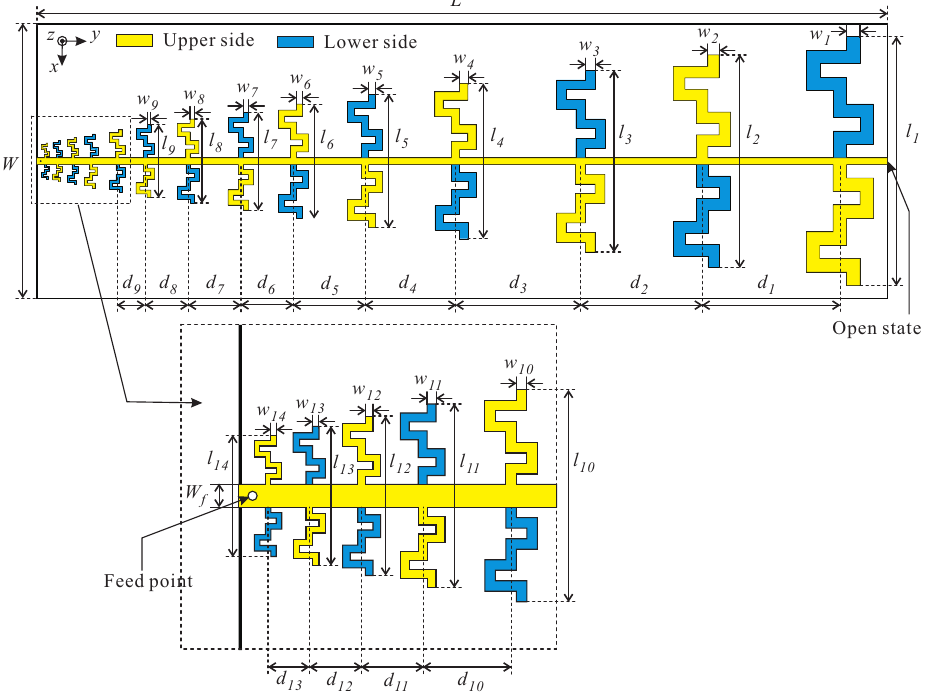
Figure 1. Configuration of the log-periodic meandered dipole array (LPMDA)